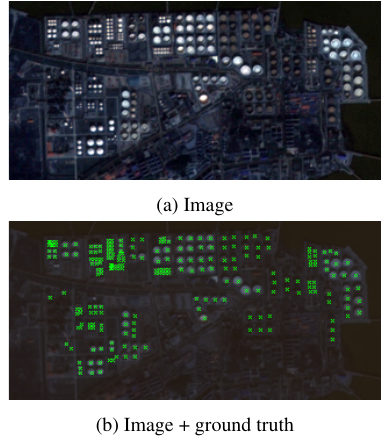
Figure 9. Image and ground truth of the validation site.